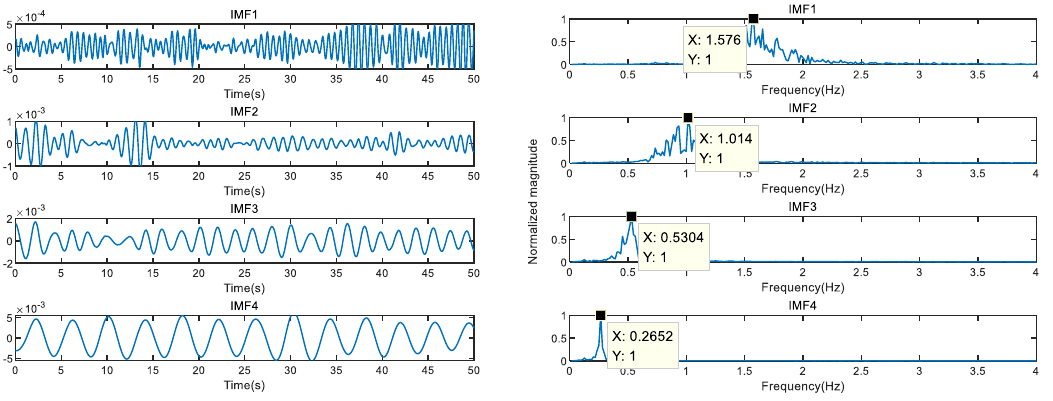
Figure 7. The original vital signs signal time domain and spectrum of target.